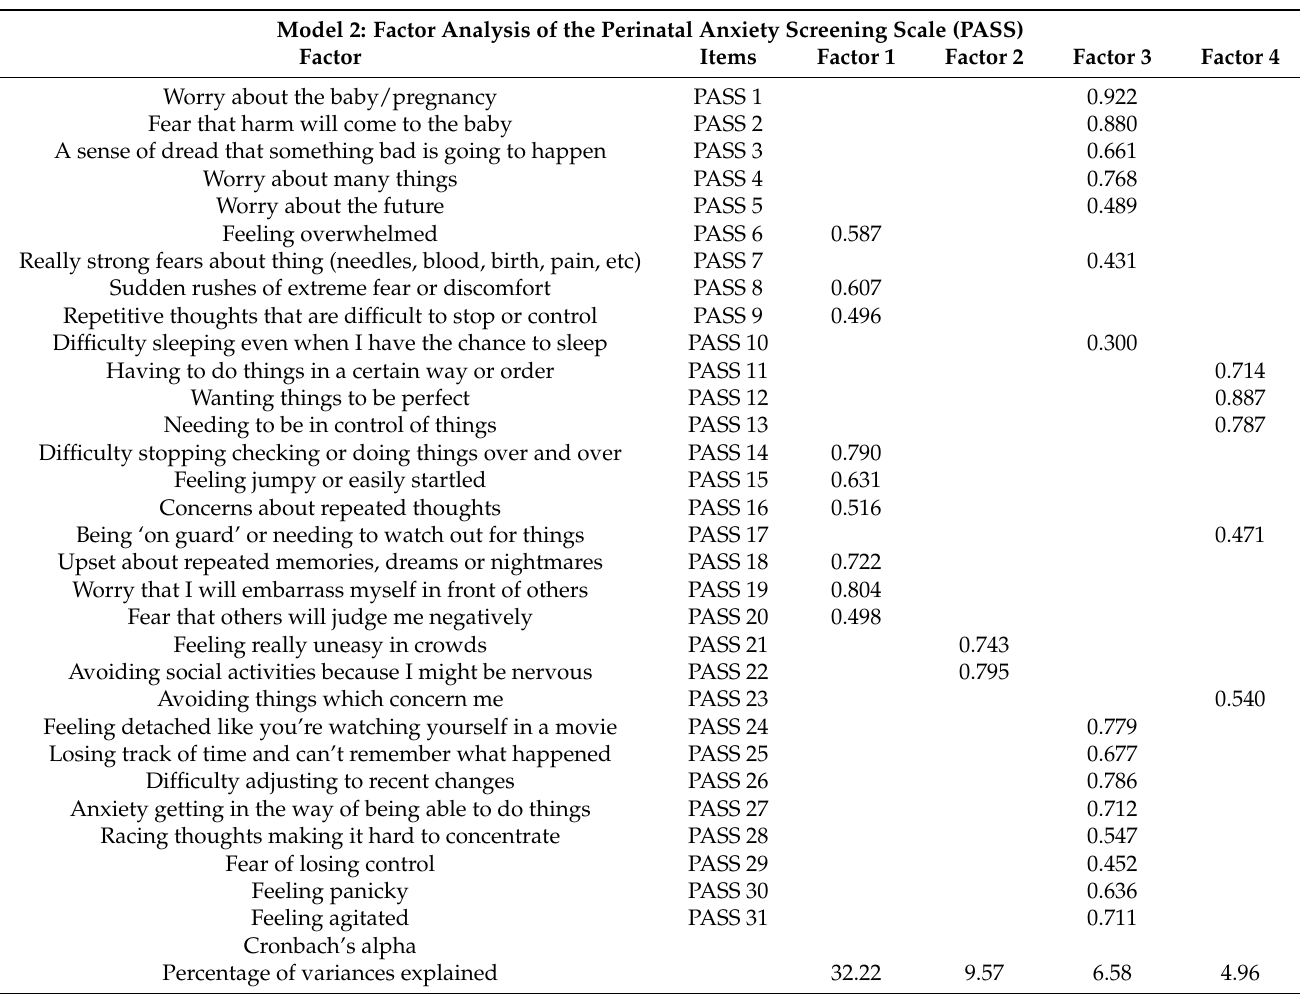
Table 2. Cont. Model 2: Factor Analysis of the Perinatal Anxiety Screening Scale (PASS)